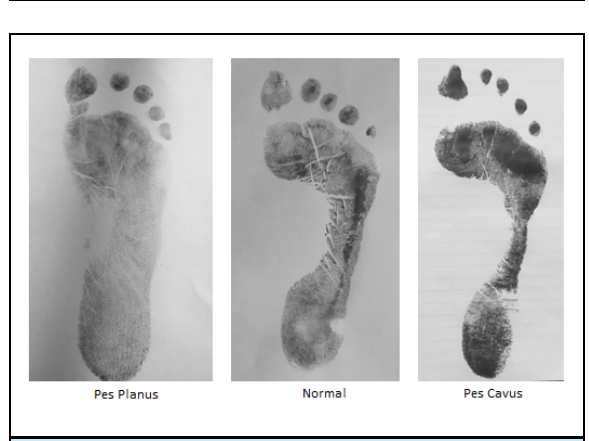
Figure 2. Types of